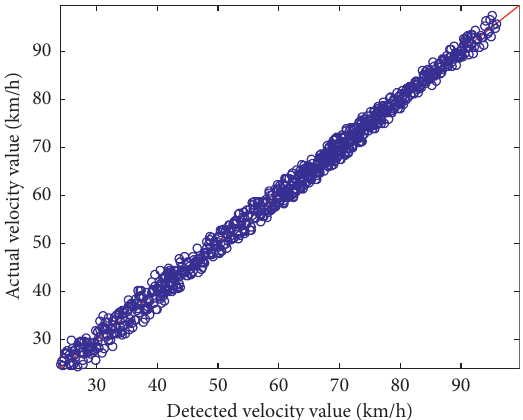
Figure 6: Actual velocity value and the detected velocity value for one